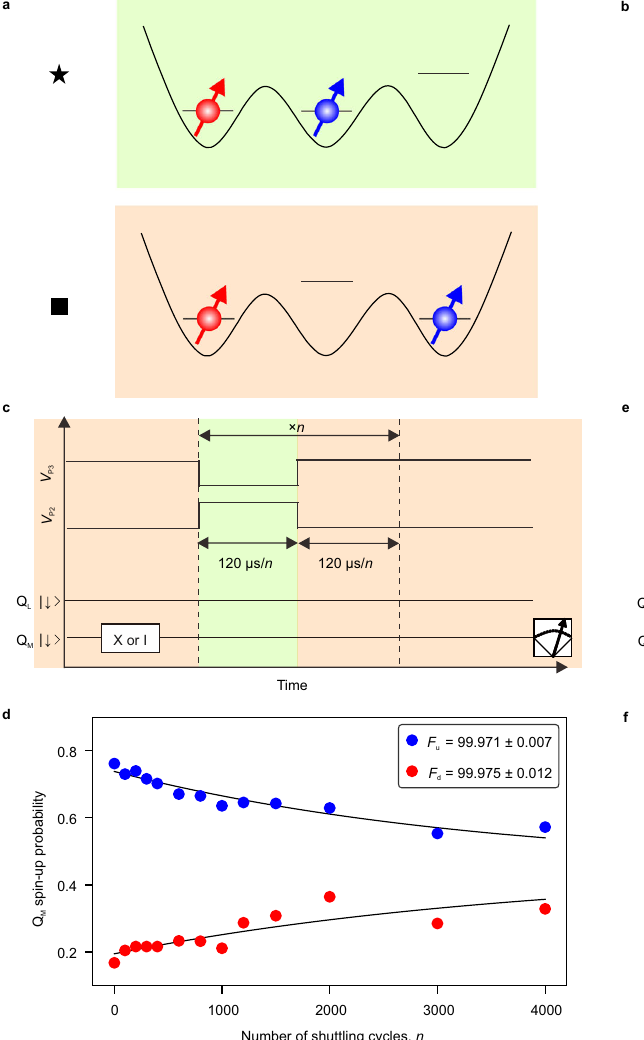
exponential decaying function (black curves). The errors represent the estimated standard errors for the best- fi t values. e Pulse sequence used to measure the amplitude in ( f ). A π rotation in the middle of the repeated shuttling cycles decouples quasi-static noise 26 . In addition, to eliminate the dephasing effect dependingontime,thetotaltimespentateachdotis fi xedat1.2 µ sindependentof n . f Number of shuttling cycles dependence of preservation of the spin phase coherence. The phase of the fi nal π /2 rotation is varied to extract the oscillation amplitudes. We obtain the preservation fi delity F p of the spin phase coherence by fi tting the data with an exponential decaying function. The errors represent the estimated standard errors for the best- fi t